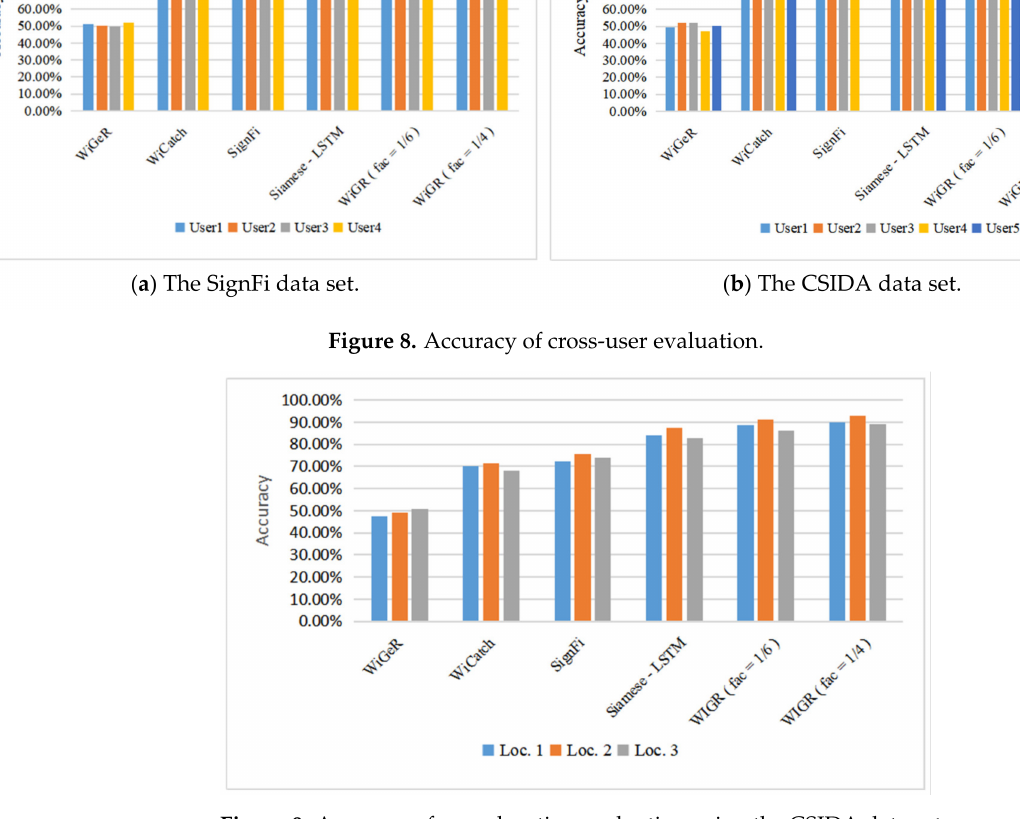
Figure 9. Accuracy of cross-location evaluation using the CSIDA data